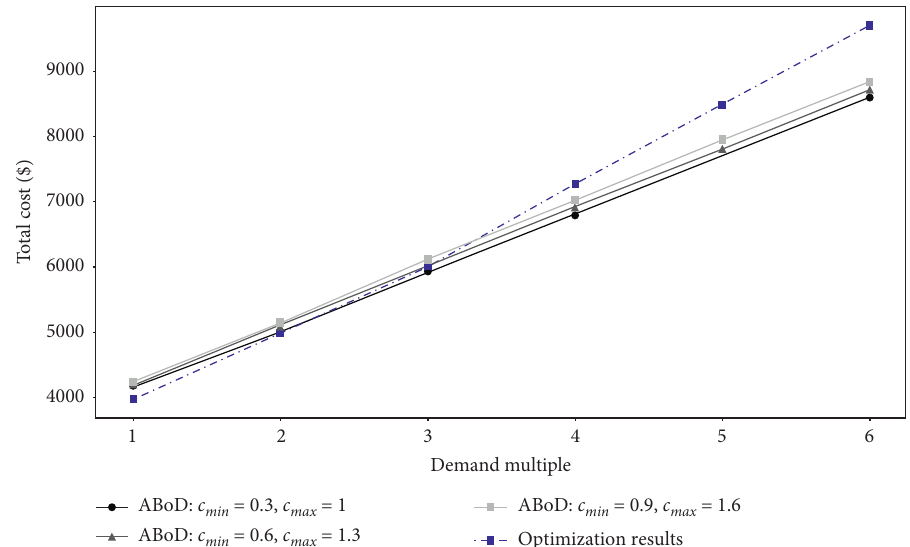
Figure 11: The impact of sudden passenger flow on ABoD and optimization